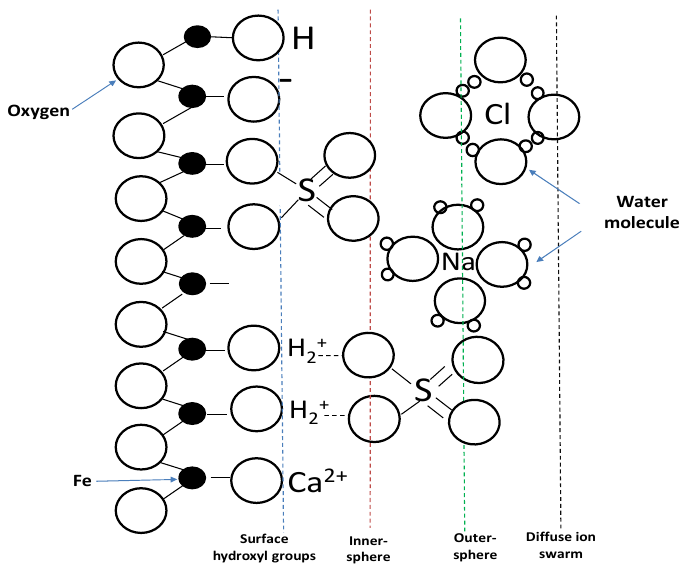
Figure 8. A schematic surface complex structure of the hydrous iron oxide surface, showing planes associated with surface hydroxyl groups, inner-sphere complexes, outer-sphere complexes, and the diffuse ion swarm (Modified from Stumm (1995) [25]).